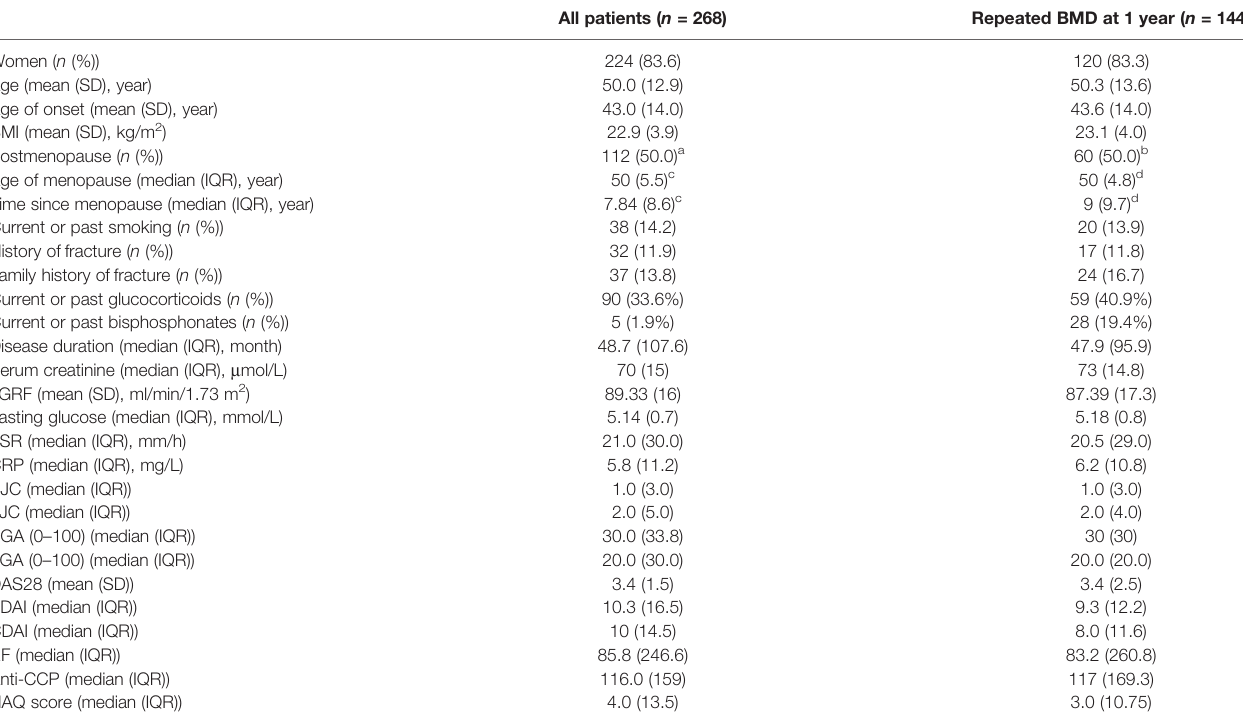
TABLE 1 | Baseline characteristics of 268 RA patients and those repeated BMD at 1